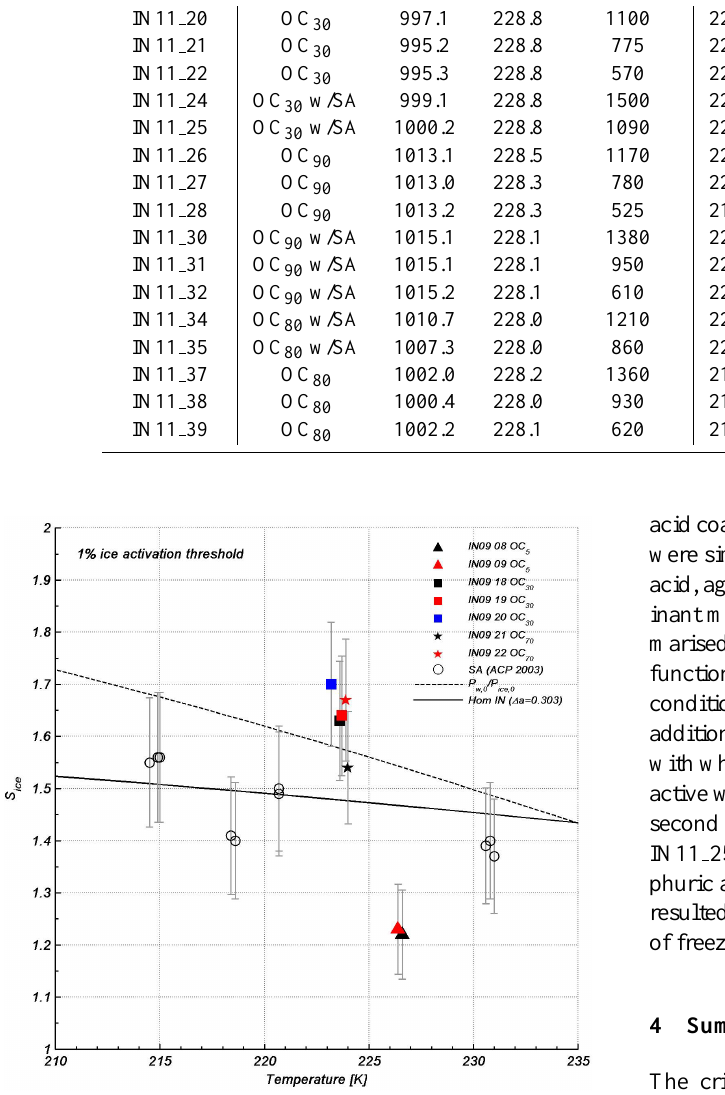
Fig. 7. Summary of T and S ice for the onset of freezing for the OC 5 , OC 30 and OC 70 flame soot particles during IN09 experiments. The dashed line indicates water saturation as given by Murphy and Koop (2005). For comparison the homogeneous freezing of pure sul- phuric acid droplets are shown (ACP 2003) from previous AIDA studies M¨ohler et al. (2003) along with the homogeneous freezing threshold, (Hom IN) of supercooled solution droplets Koop et al. (2000), indicated by the solid line, where 1a is the fitting parameter used as described in M¨ohler et al. (2003) to calculate the homoge- neous freezing